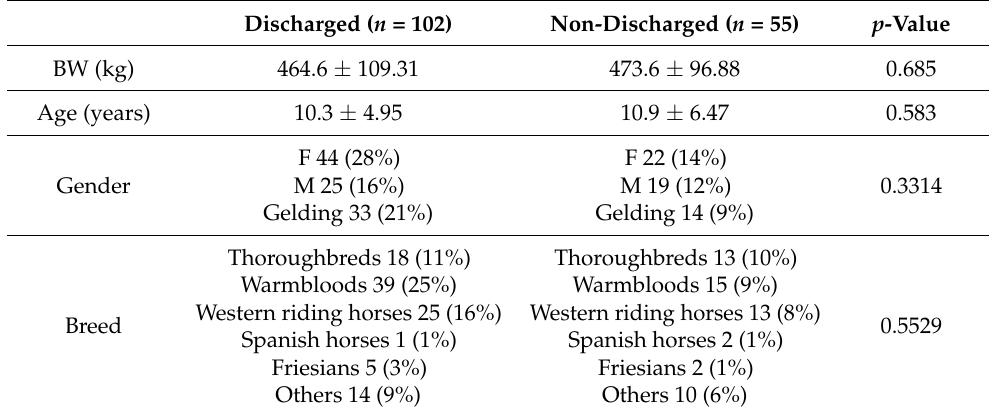
Table 2. Comparison of signalment findings in discharged and non-discharged horses (BW: body weight; F: female; and M: